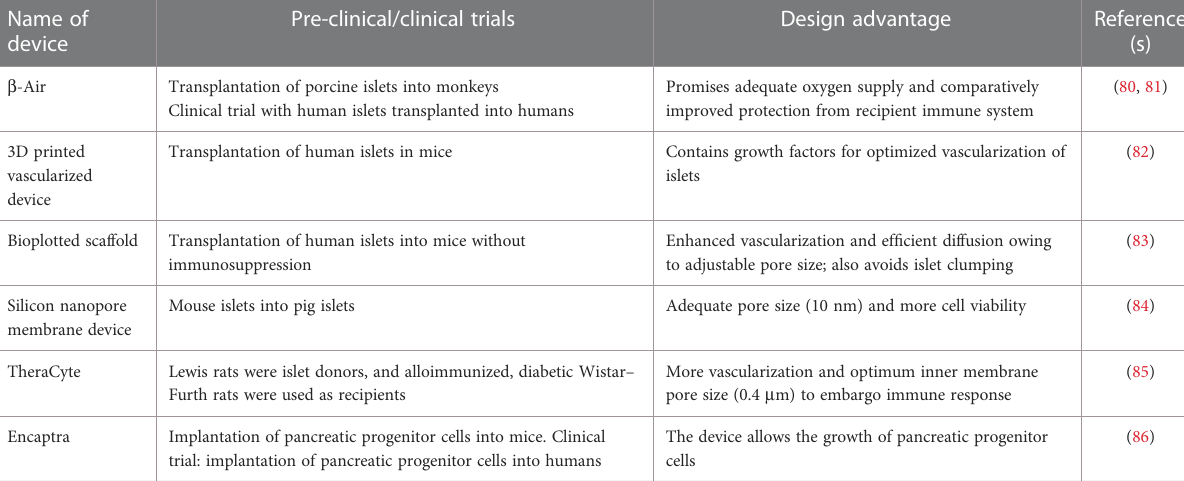
TABLE 3 Enumeration of devices containing macroencapsulated islets being used in various preclinical and clinical trials. Name